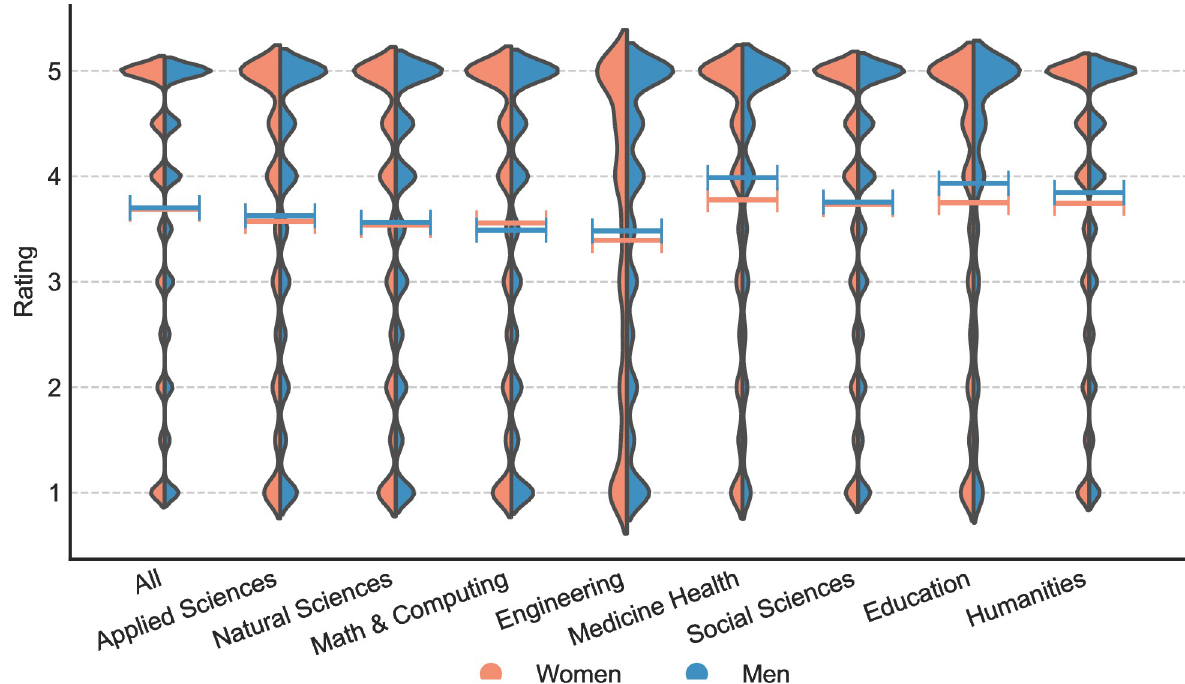
Fig 4. Rating distributions and means of by professor gender and field. Horizontal Lines in violins denote the mean values.